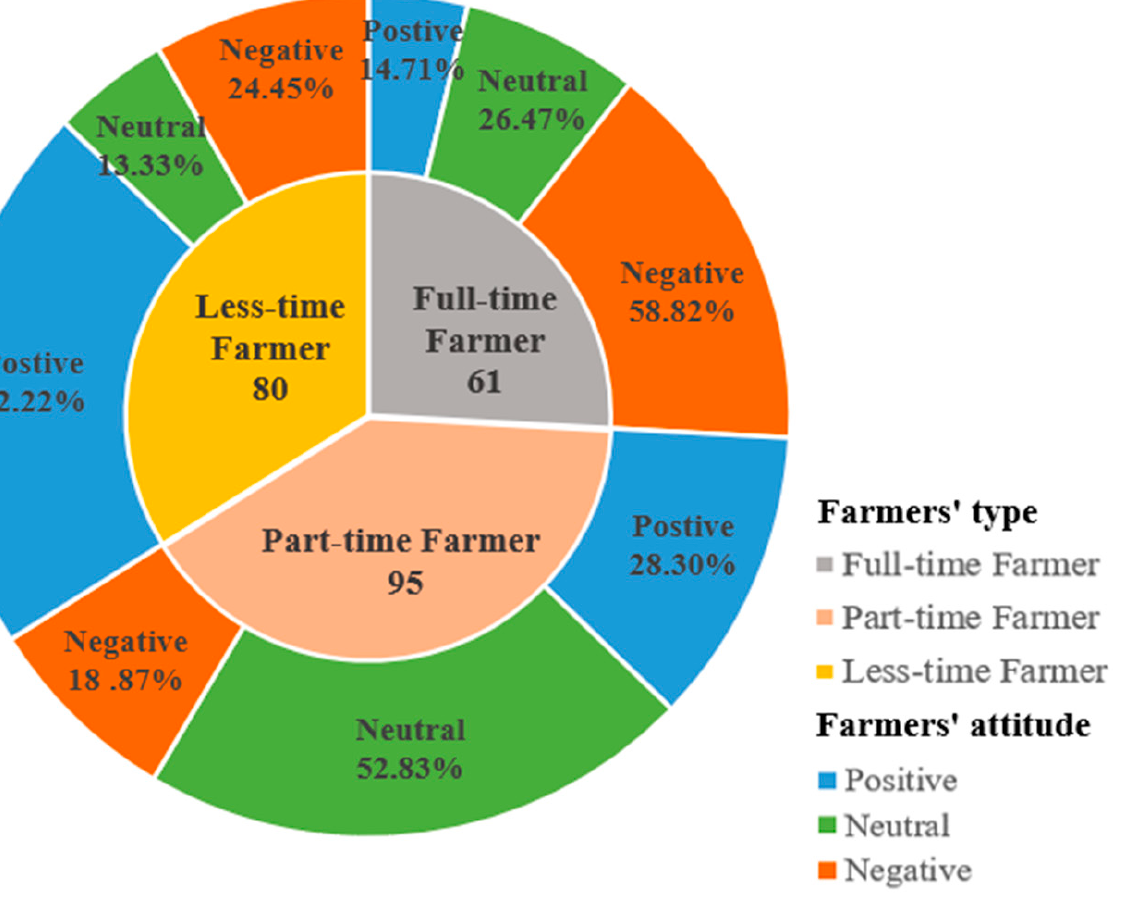
Figure 5. The farmers’ attitudes towards land requisition based on different livelihoods.